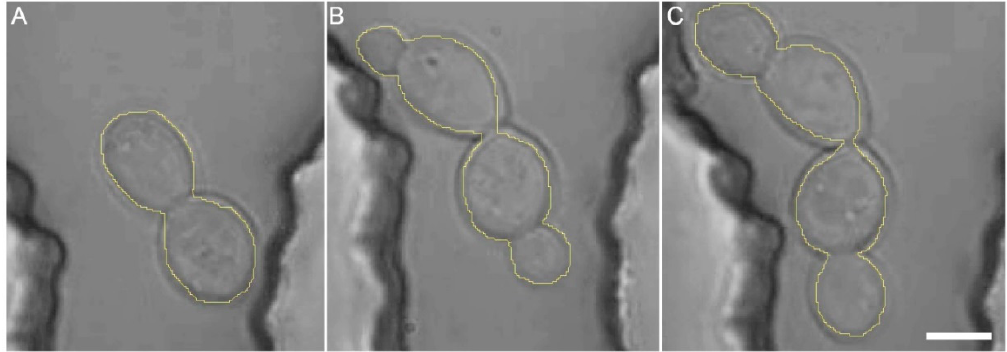
Figure 4. Measurement of area occupied by budding Saccharomyces cerevisiae cells. Time-lapse images of a budding yeast cell are shown in 30 min increments from ( A – C ). The area of the cells in terms of the number of pixels was measured manually on the images by marking the circumference of the cell mass (yellow line) and calculating the area of circumference region in ImageJ software. Scale bar length: 5 μ m.